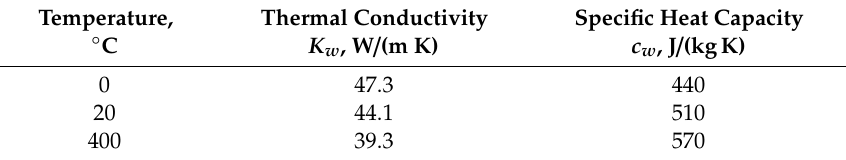
Table 5. Thermal properties of the wheel material (ER7 1 steel)